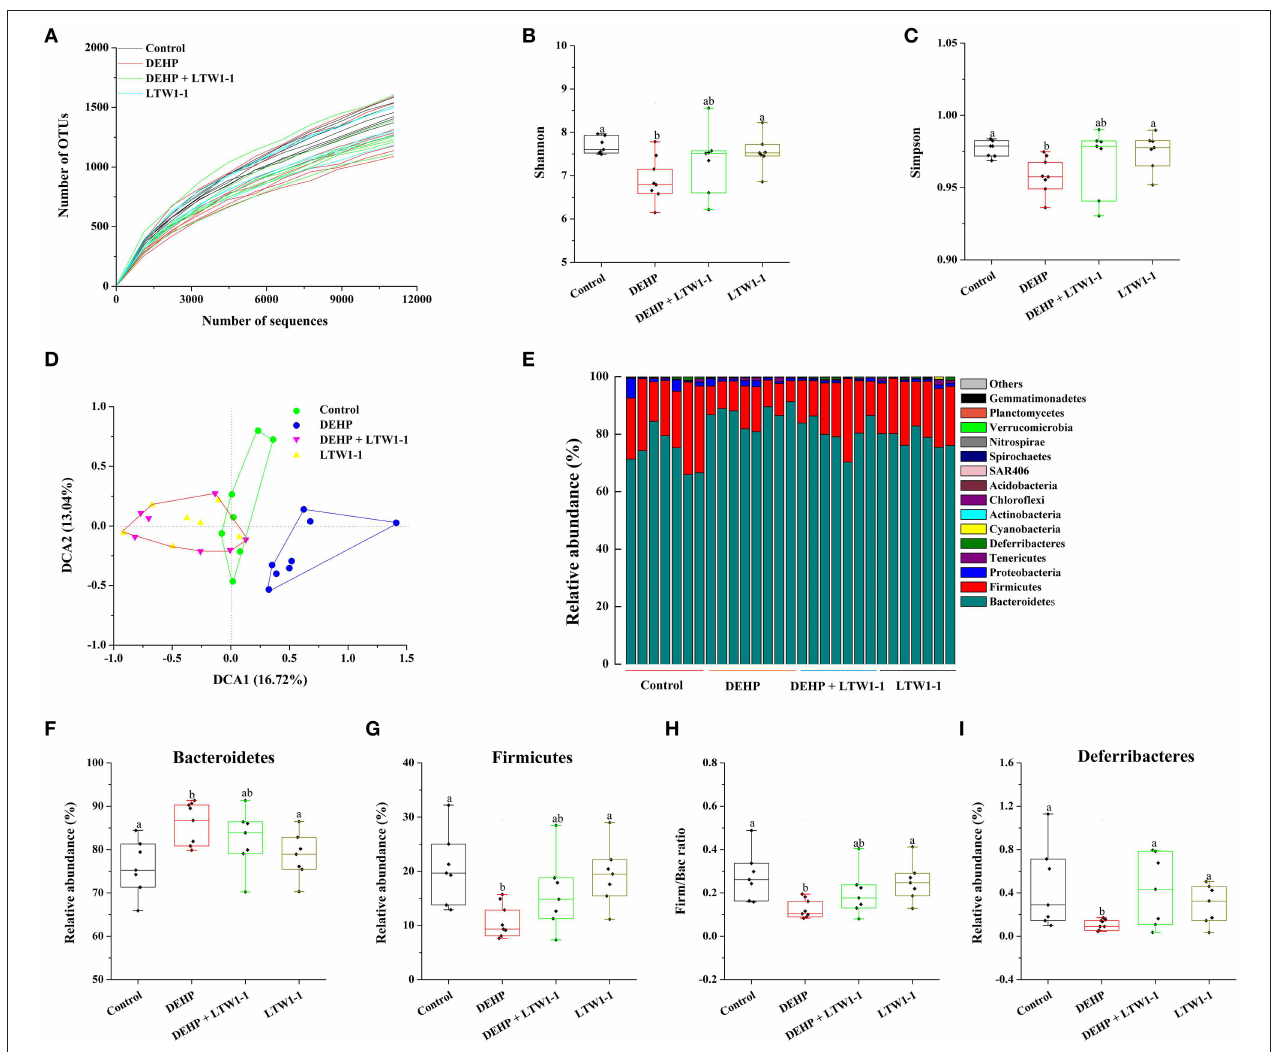
FIGURE 5 | Effects of L. plantarum TW1-1 treatment on the structural changes and microbial diversity of the gut microbiota in DEHP-exposed mice. (A) Rarefaction curve. (B) Bacterial diversity as assessed by the Shannon index. (C) Bacterial diversity as assessed by the Simpson index. (D) DCA of fecal microbiota in the four groups. (E) Relative abundance of each fecal microbial profile at the phylum level in the four groups. (F,G,I) Relative abundances of significantly changed bacterial phyla ( Bacteroidetes , Firmicutes, and Deferribacteres ). (H) The Firm/Bac ratio in the different groups. The data are expressed as mean ± S.E.M. ( n = 7–8), different letters represent significant differences between groups by Tukey’s test ( P <